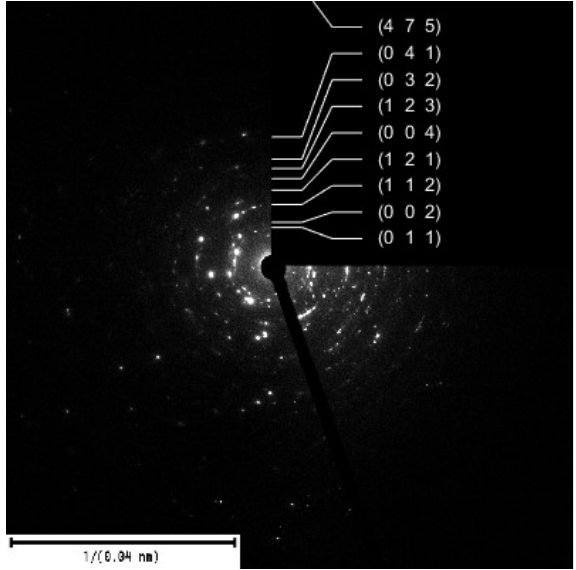
Figure 10. Selected area diffraction (SAED) sublayers adjacent to the substrate, indexed by the TiAl phase.